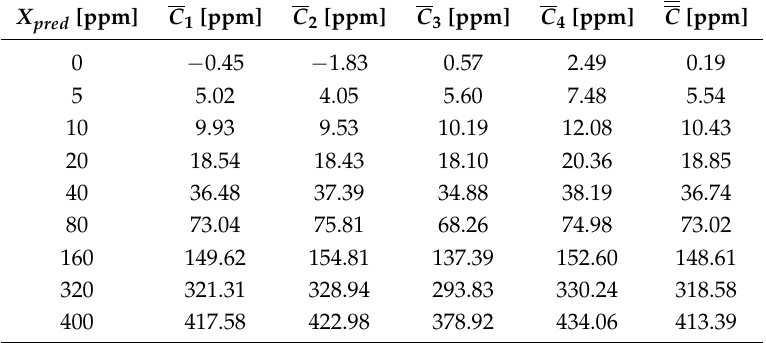
Table 10. Data of the experiment containing the predicted concentration, each steady-state value of the four OiW monitors based on OLS calibration, and the grand mean of all four monitors for each